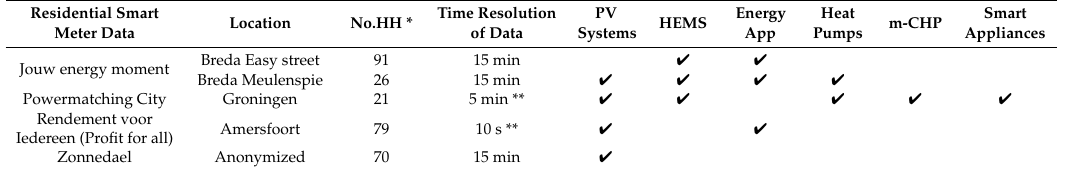
Table 1. Summary of the main features of the smart grid pilots, their data, and the reference dataset. Residential Smart Meter